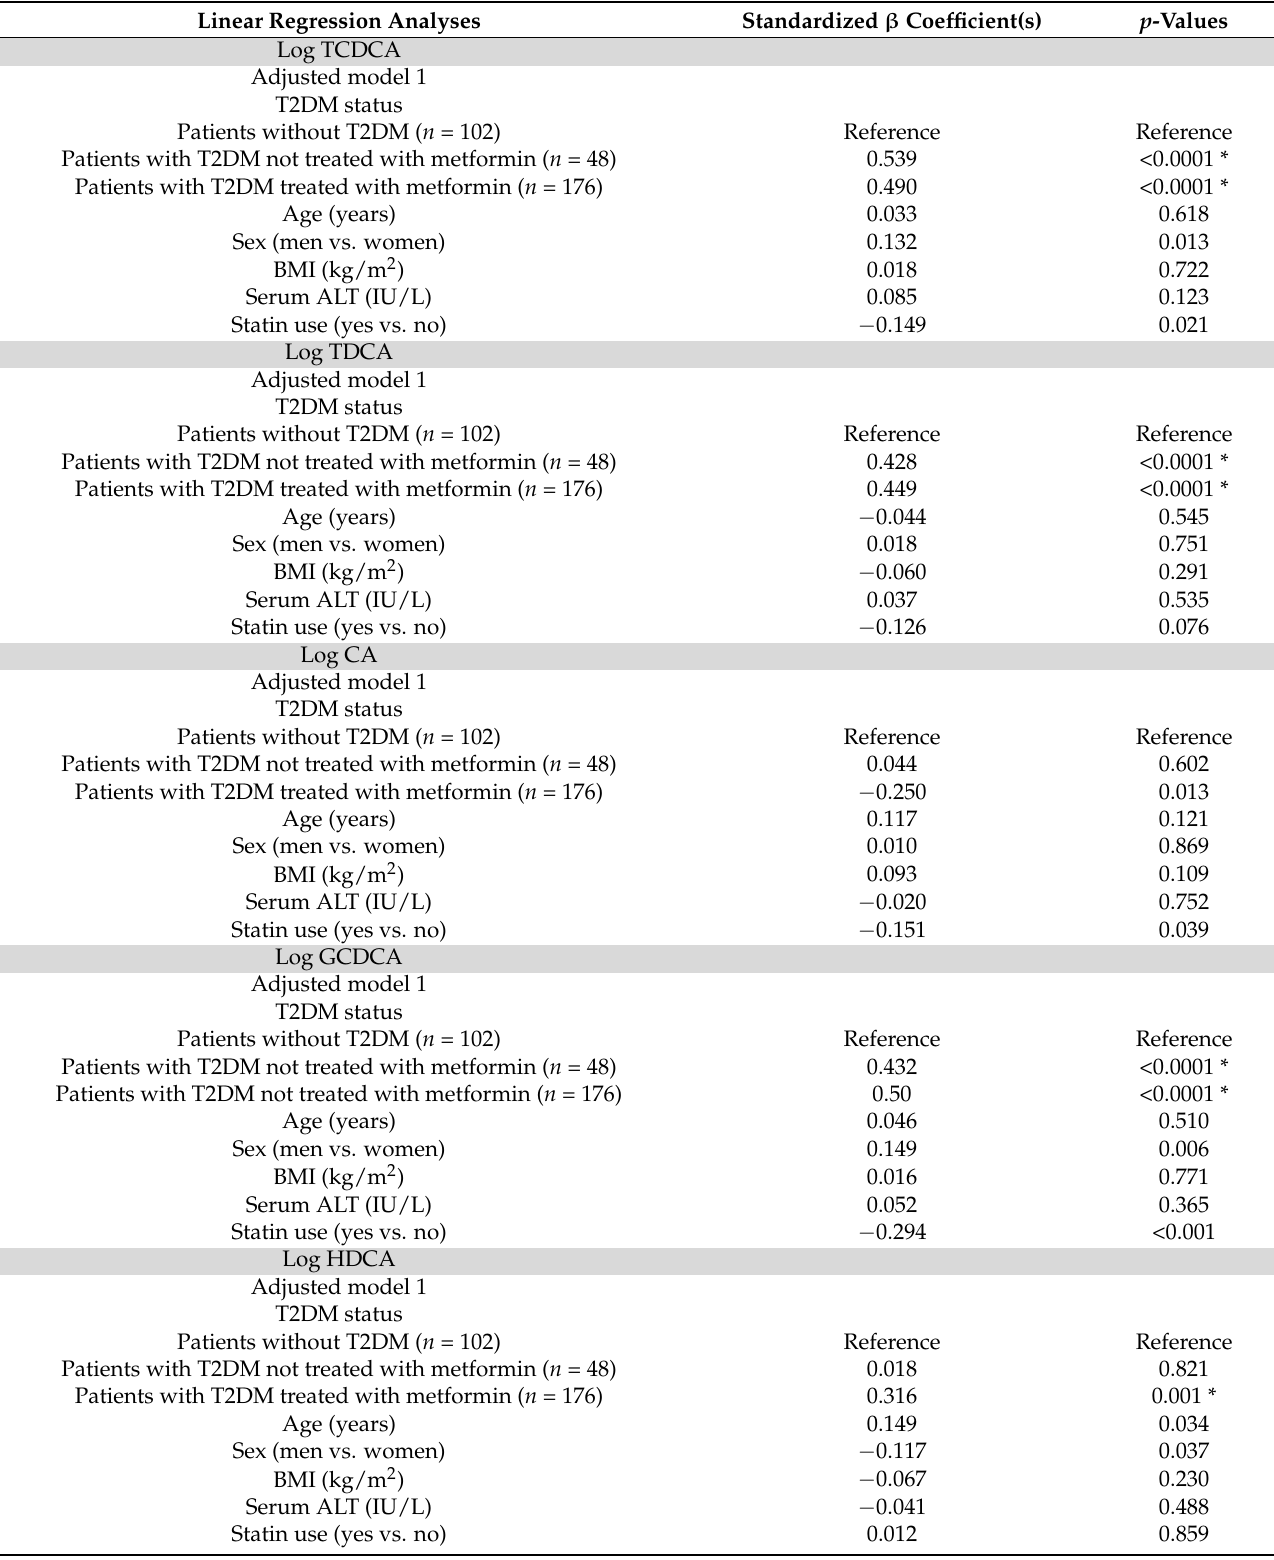
Table 5. Linear regression analyses—Adjusted associations between plasma bile acid concentrations and presence/absence of type 2 diabetes mellitus (T2DM) treated with or without